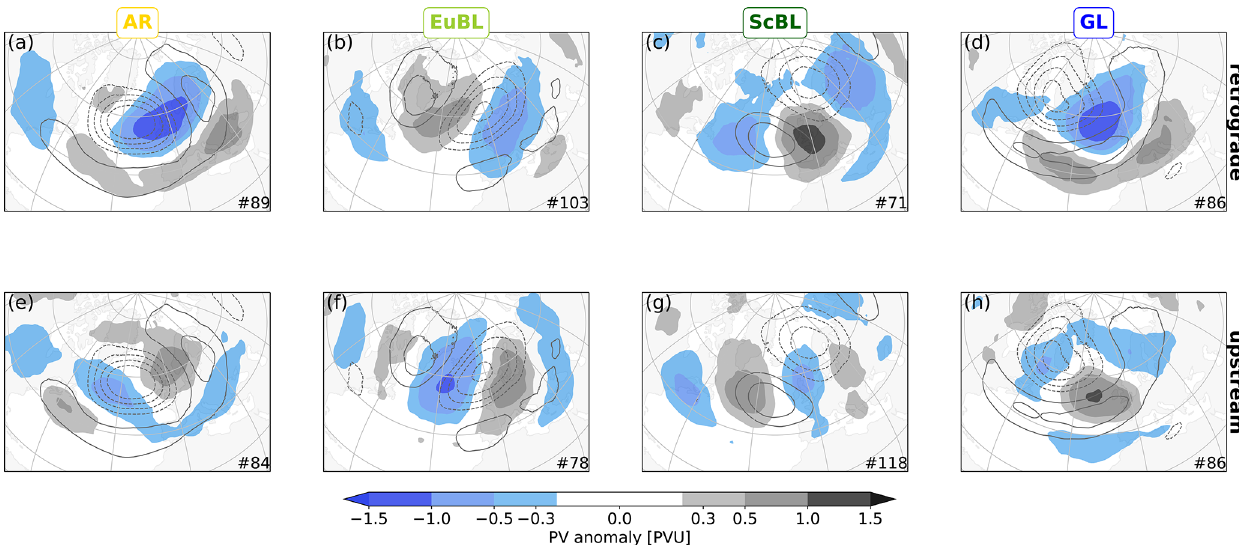
Figure 8. Same as Fig. 3, but for the retrograde (a–d) and upstream cluster (e–h) , averaged over 1–3d before onset.